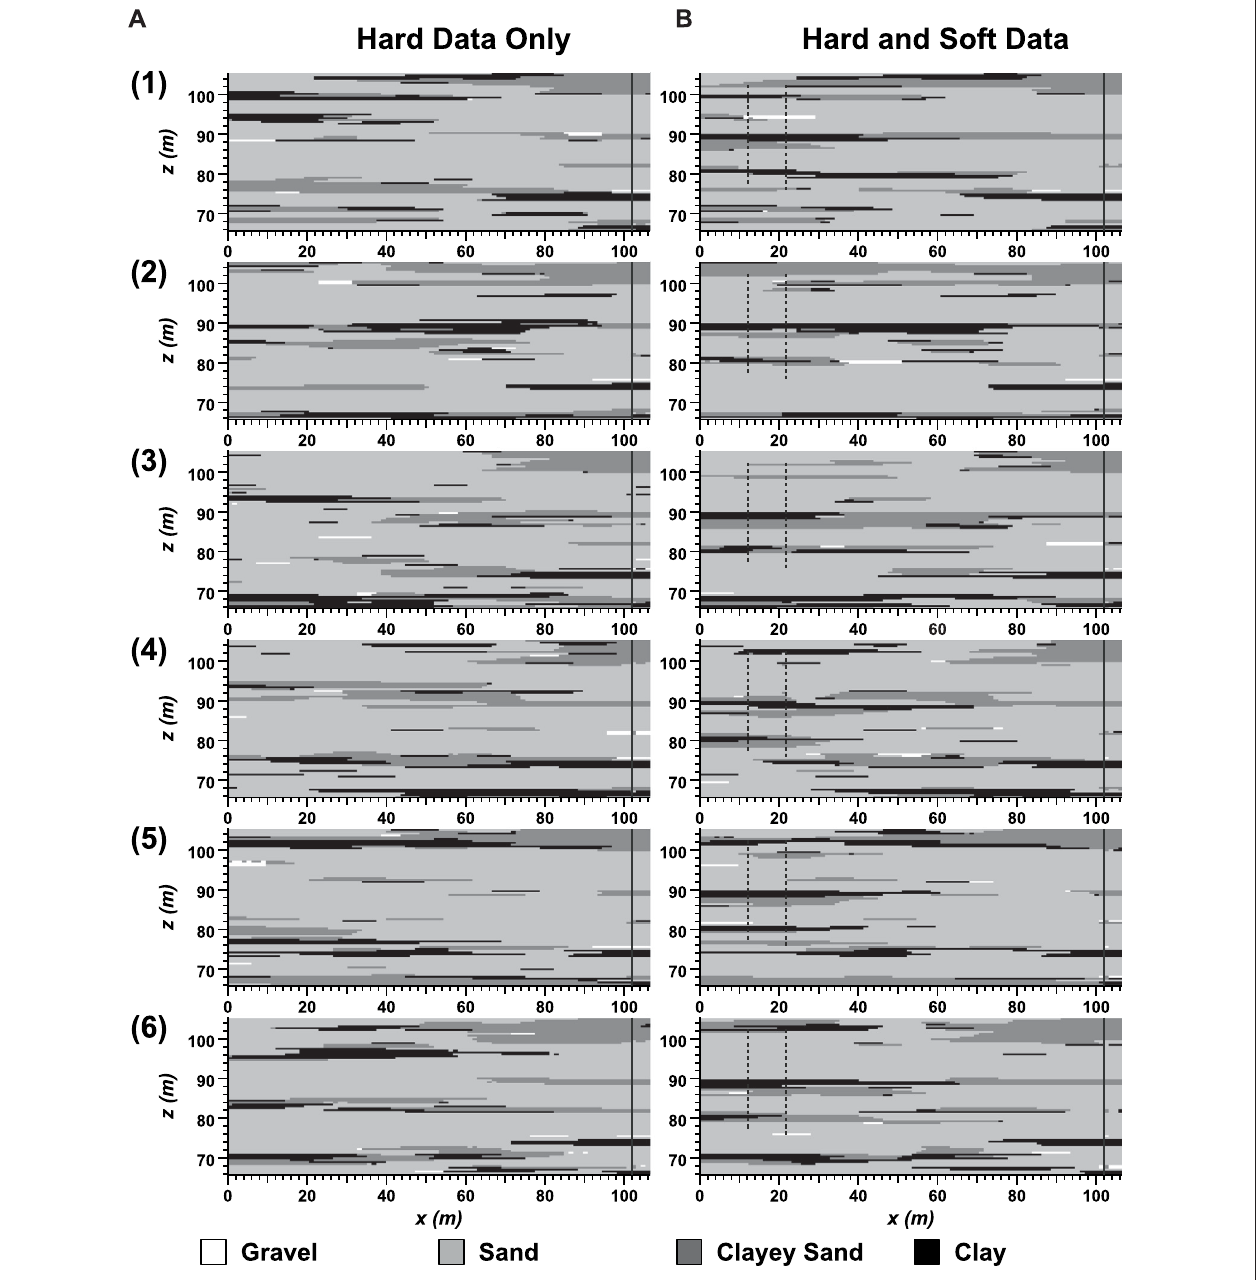
FIGURE3| Sixlithofaciesrealizationsgeneratedforcaseswith (A) harddataonlyand (B) hardandsoftdata.Harddatalocationsareindicatedbysolidlineatright, and soft data locations are indicated by dashed lines at left in (B) .